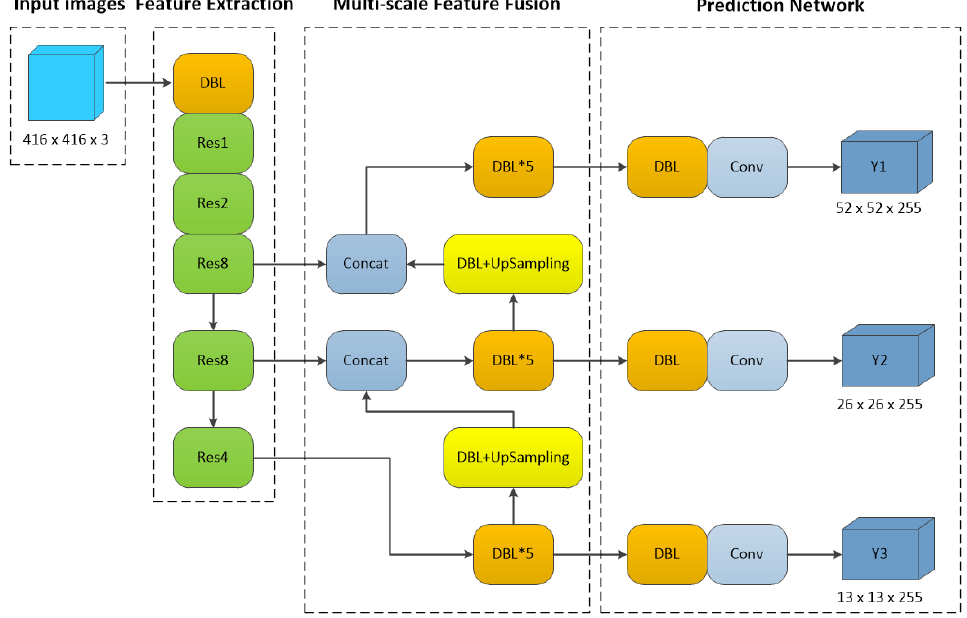
Figure 4. YOLO-V3 network